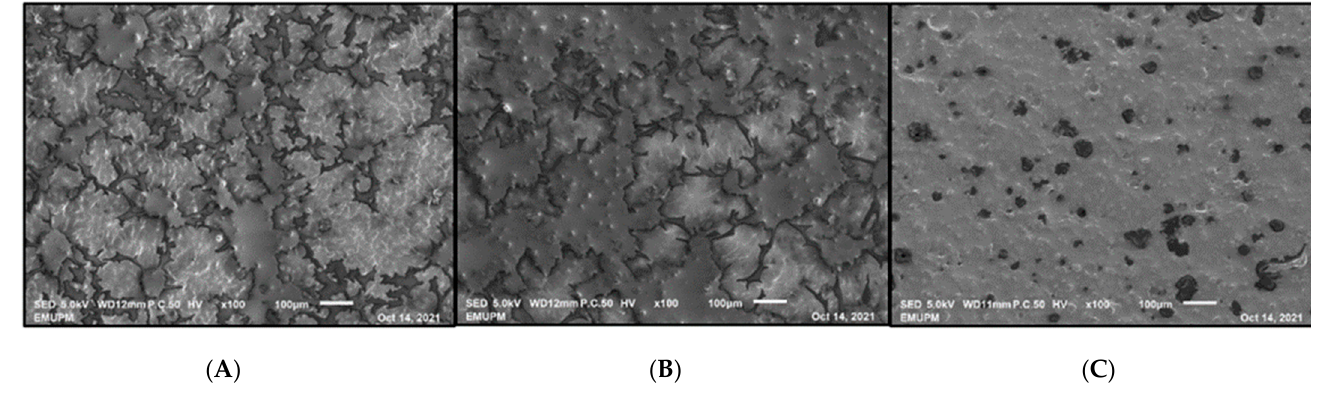
Figure 1. Microstructure images of ( A ) EGA, ( B ) EGB and ( C )